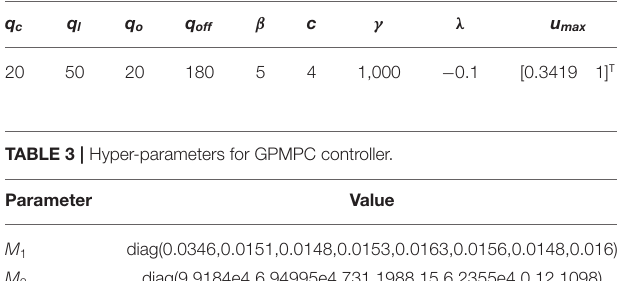
TABLE 2 | Parameters of the NPMC controller.